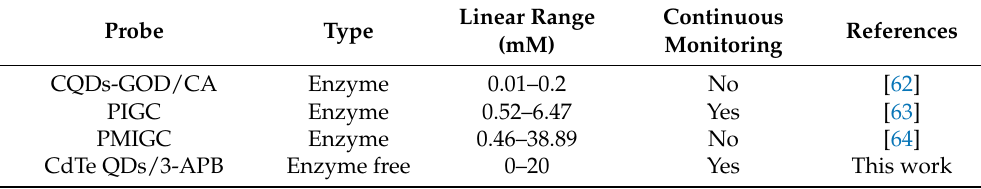
Table 1. Comparison of the proposed sensor with other glucose detection methods.